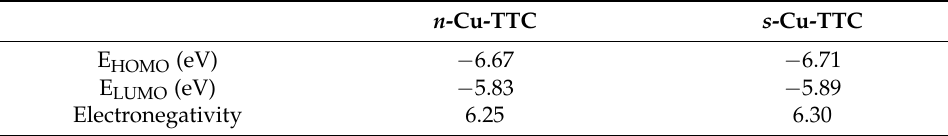
Table 3. Frontier orbital energies and electronegativity.